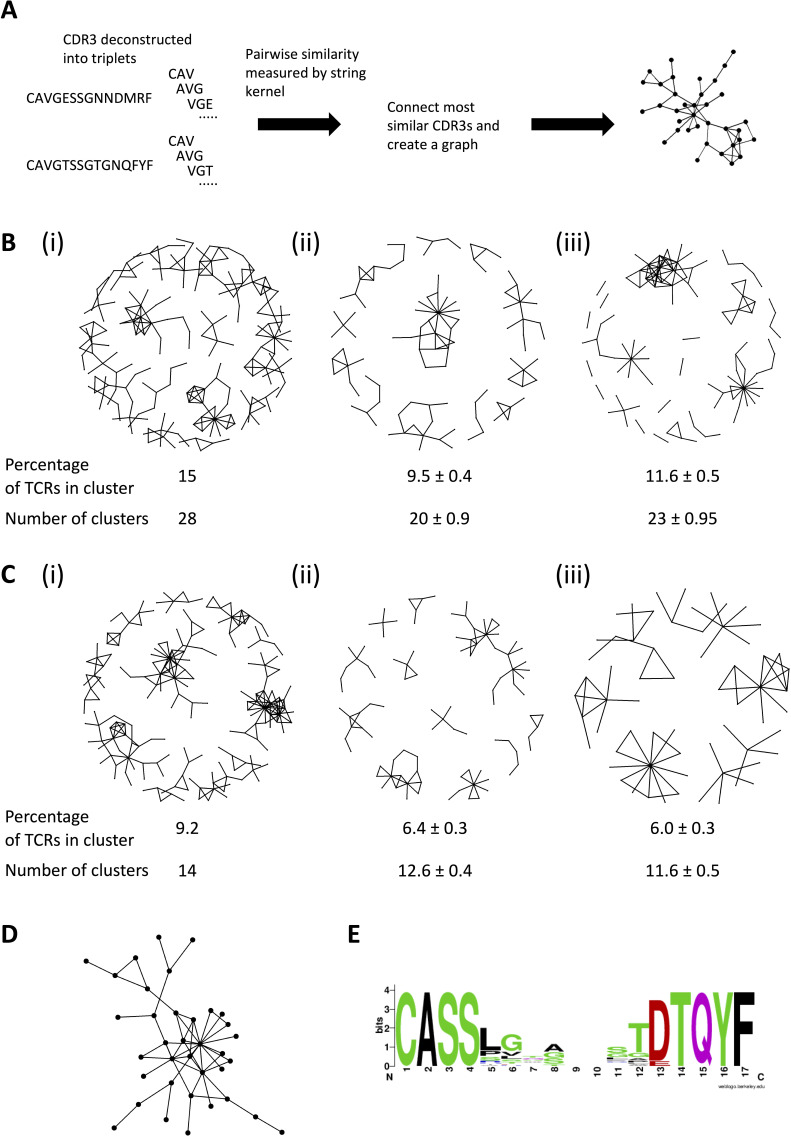
The expanded T cell receptors (TCRs) show clustering characteristics of antigen-driven responses.(A) Diagram illustrating the similarity graph construction process. Individual CDR3s are deconstructed into overlapping series of contiguous amino acid triplets, and the pairwise similarity between two CDR3s is calculated as the normalized string kernel. Two CDR3s which have a pairwise similarity of >0.75 are connected by an edge. (B) Clusters formed from the CDR3 sequences of (i) the PT1 expanded alpha TCRs (≥ 8), (ii) an equal-sized (1858) set of alpha TCRs sampled randomly from the combined pre-sensitization repertoires of the same patients, and (iii) a size-matched set randomly sampled from the combined healthy volunteer alpha TCRs. The numbers under each network diagram show the percentage of the 1858 TCRs which are incorporated in a cluster, and the number of clusters. The numbers for the pre-sensitization and healthy volunteers show the average ± standard error of the mean for each parameter. (C) As (), but for beta sequences (2019 expanded TCRs, or the same number of control TCRs). (D) The largest (35 unique CDR3s) cluster of PT1 expanded TCR beta sequences, from panel (C) (i). (E) An alignment of CDR3 sequences from the cluster shown in panel (D). The alignment is illustrated as a sequence logo (https://weblogo.berkeley.edu/logo.cgi). The full alignment is shown in Supplementary file 5.